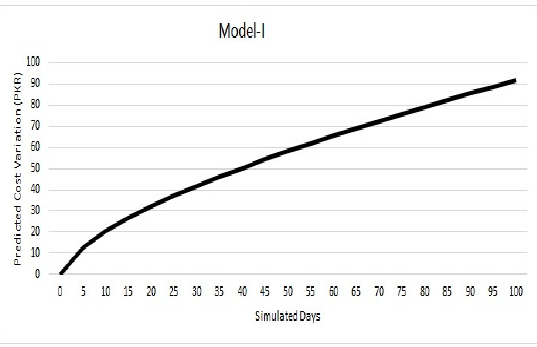
Fig. 2: Interpretation of Model-I Regression Equation